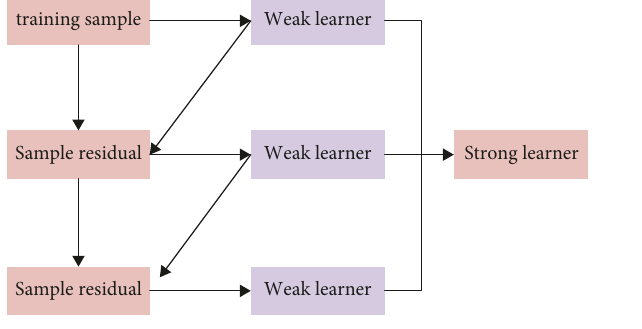
Figure 2: GBDT algorithm flowchart.